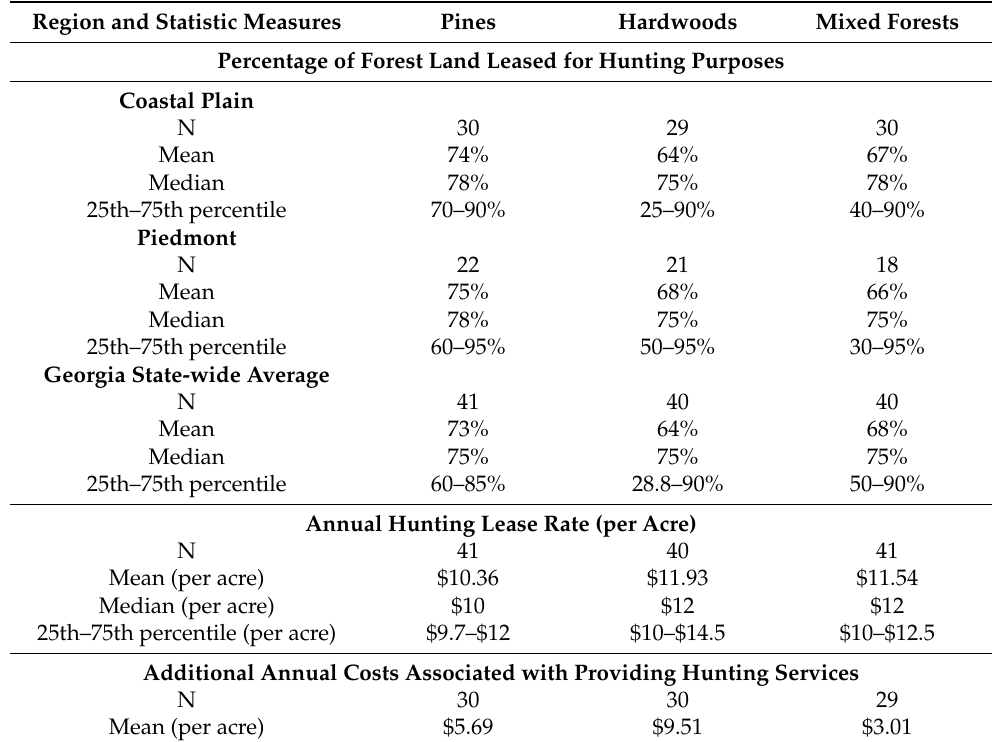
Table 4. Estimated percentage of forest land leased for hunting purposes by forest type and region in Georgia and average hunting lease rate.